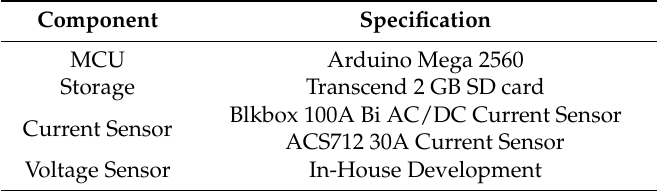
Figure 4. Operation concept of power transmission during the day. Table 1. Specifications of the photovoltaic power management system (PPMS).